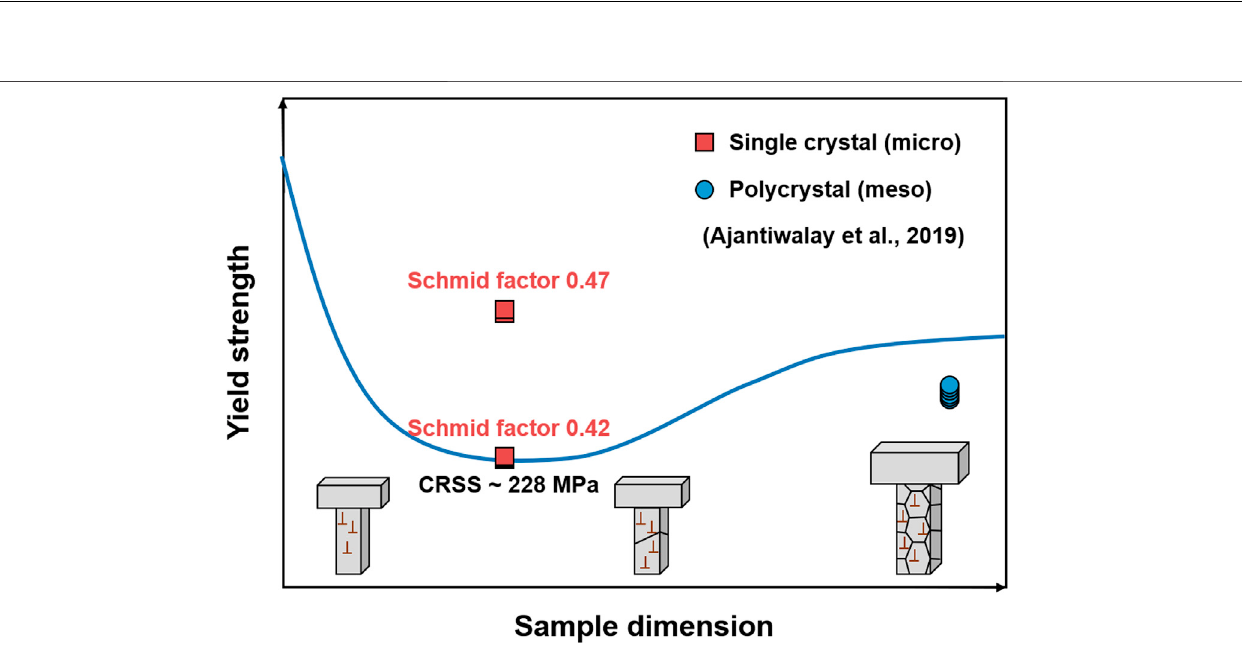
Frontiers in Materials |